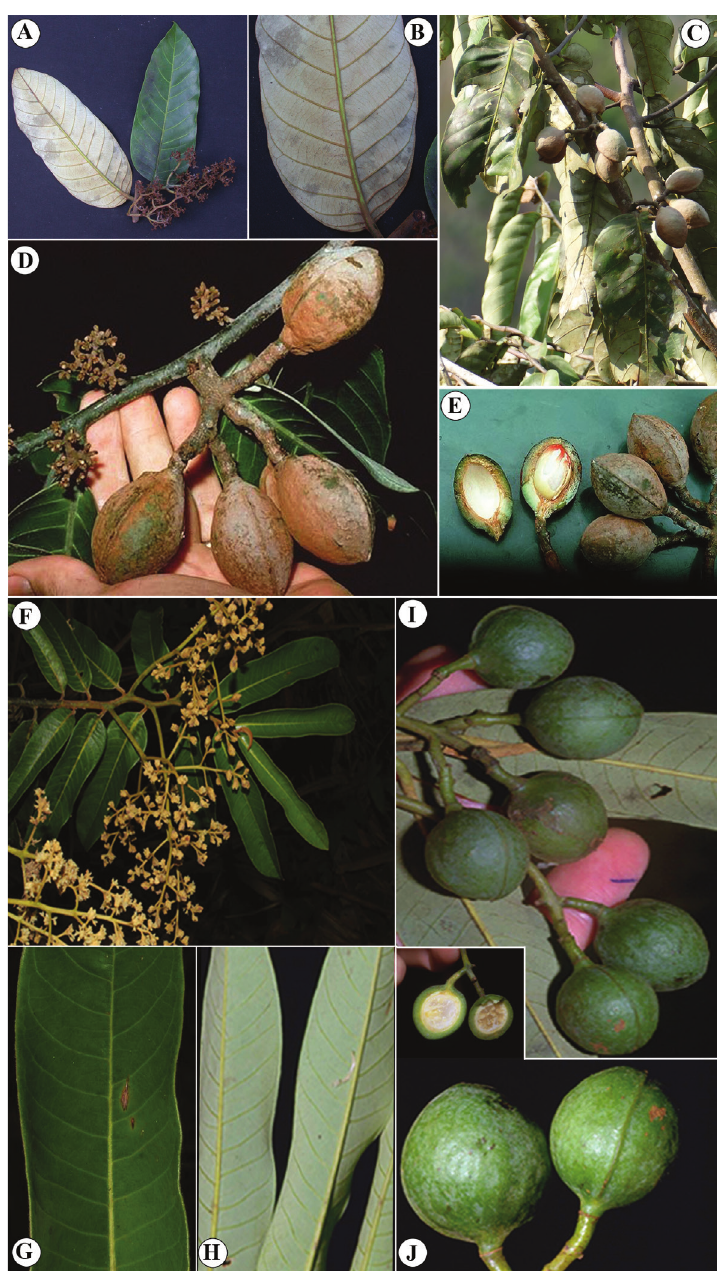
Figure 23. Virola otobifolia A branch with leaf blades showing both surfaces and inflorescences B leaf blade, venation and base on abaxial surface C infructescence D fruits E detail of fruit, showing an aril of an imma- ture fruit. Virola surinamensis . F Branch with inflorescences G, H leaf blade on adaxial ( G ) and abaxial sur- face ( H ). I Infructescence J detail of fruits, including a longitudinal section of an immature fruit. Photos by Rolando Pérez ( A, B from https://stricollections.org/portal/index.php); Jerry Harrison ( C ), Alwyn H. Gen- try ( D, E from http://www.tropicos.org) and John P. Janovec ( F–J from